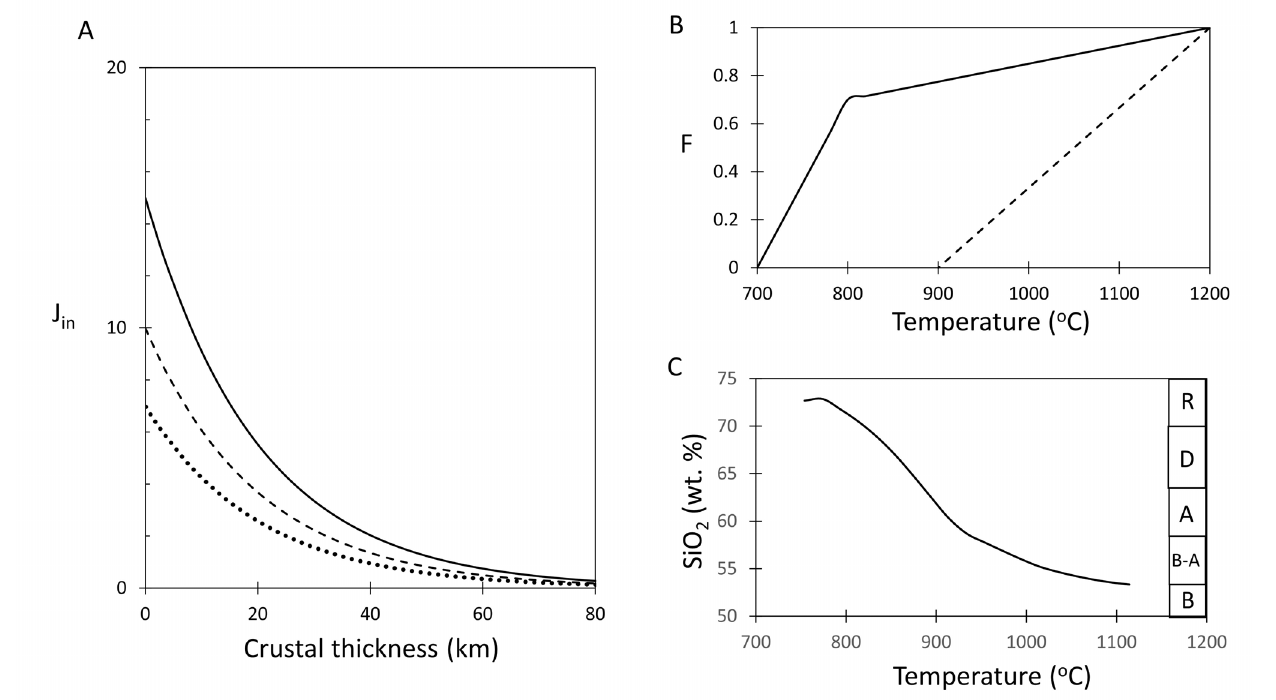
as a function of crustal thickness. J at zero crustal thickness cor- Figure 4: [A] Modeled magmatic flux J in in responds to J o , the hypothetical baseline magmatic flux from the mantle, which we equate with the baseline in recharge flux. J decays exponentially with increasing crustal thickness because thick crust limits the extent of in decompression melting in the mantle. [B] Idealized melt productivity curves for hydrous and anhydrous systems used in models. Given variability based on different starting compositions, we use simple parameterizations to capture first order behaviors. Under hydrous conditions, solidus is depressed and melt productivity curve is highly nonlinear. [C] SiO of melt was not calculated in our models, but shown here for context is an approximate re- 2 lationship of the SiO content of residual melt versus temperature for a basaltic bulk composition with 4 wt. % 2 H O at 0.3 GPa as determined from thermodynamic modeling [Lee and Bachmann 2014]. This curve is dependent 2 on the conditions of crystallization as the exact nature of the curve depends on pressure, bulk composition and water content. Symbols on the right correspond to rhyolite (R), dacite (D), andesite (A), basaltic-andesite (B-A), and basalt